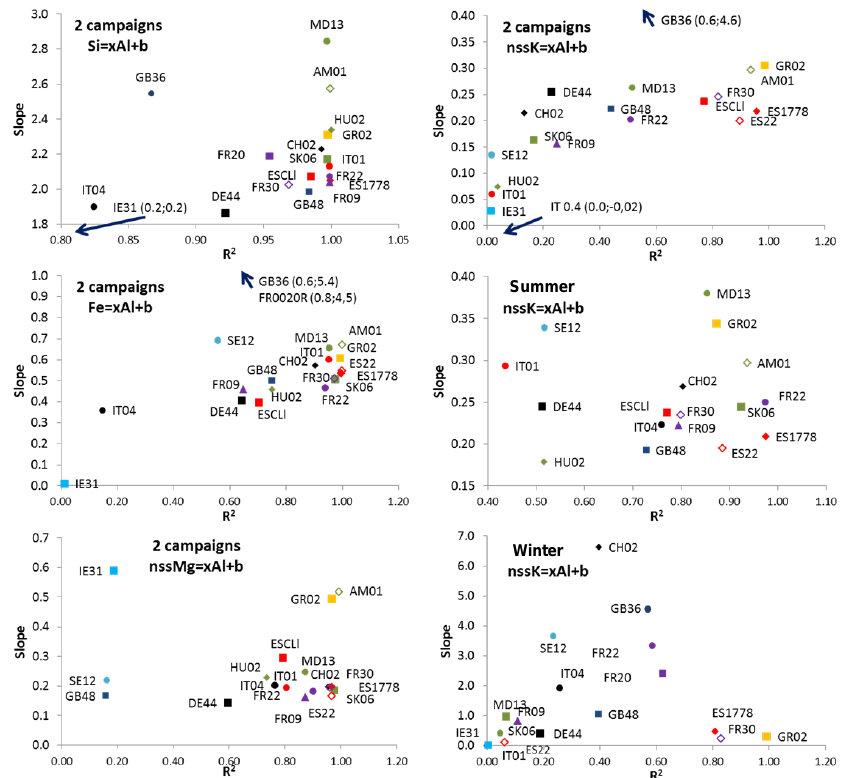
Figure 4. Scatter plots of determination coefficient vs. slope for concentrations of selected elements at the sampling sites.